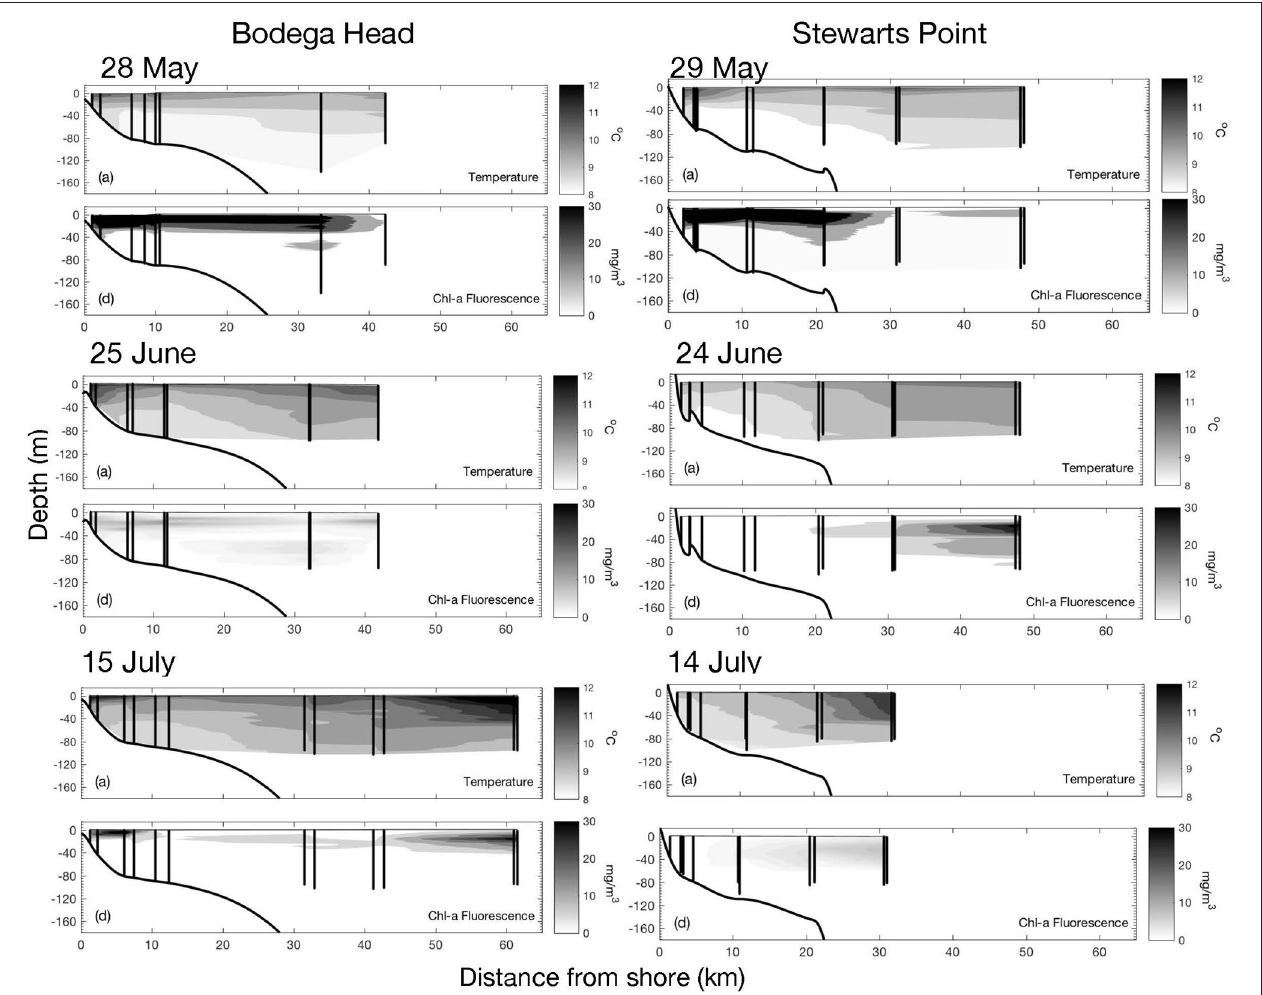
FIGURE 4 | Contours of temperature ( ◦ C) and chlorophyll-a from vertical profiles at six stations along transects off Bodega Head and Stewarts Point on 28–29 May, 24–25 June, and 14–15 July 2009. Profile locations at the beginning and end of plankton tows at each station are depicted by black vertical